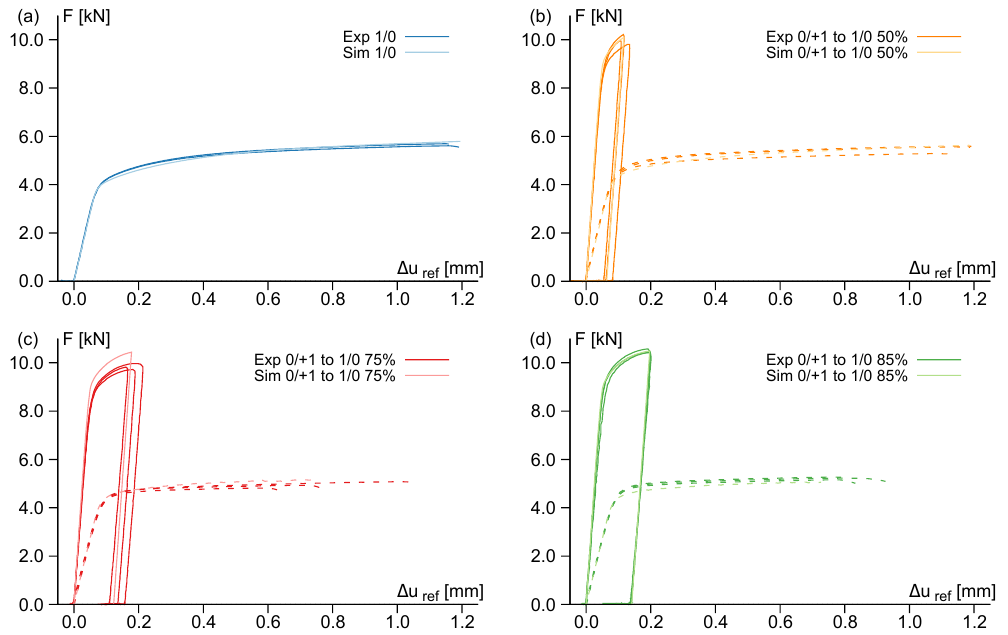
reaches F 1 = 4.6 kN and failed between ∆ u ref .1 = 0.8 mm and 0.96 mm. Thus, the different preloading paths have remarkable influence on the load-displacement behavior during the second load paths with F 1 . The reduction of maximum load is about 20%, and the final displacement is only about 70% of the displacement of the specimen without preloading history. Thus, the pre-tensile-loading of the H-specimen makes the material more brittle and may lead to earlier failure during forming processes.